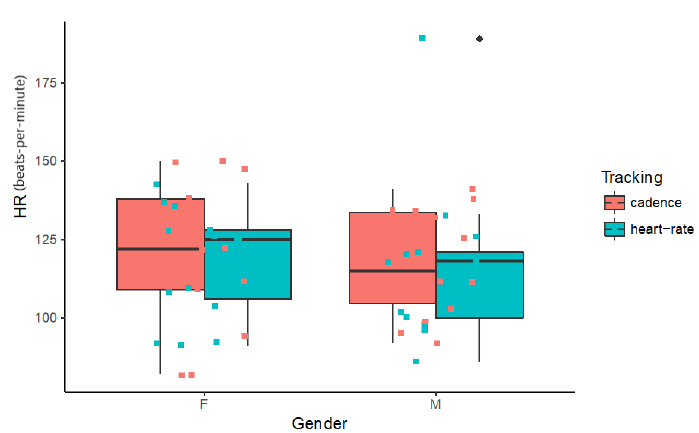
Figure 6. Boxplot for individual average heart rate (bpm) by Tracking type across Gender.